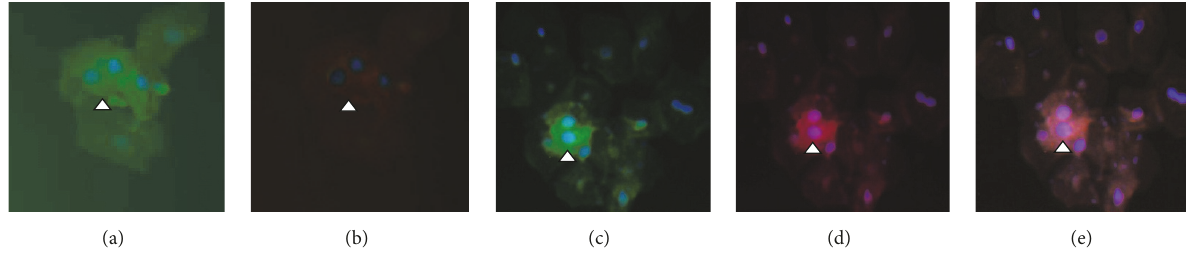
Figure 1: Expression of uPAR in urinary podocytes of patients with Fabry disease. (a) Synaptopodin negative cells (arrowhead). (b) uPAR negative cells (arrowhead). (c) Synaptopodin positive cells (arrowhead). (d) uPAR positive cells (white arrowhead). (e) Merge indicating the colocalization between synaptopodin and uPAR in Fabry podocytes (arrowhead). Magnification: ×